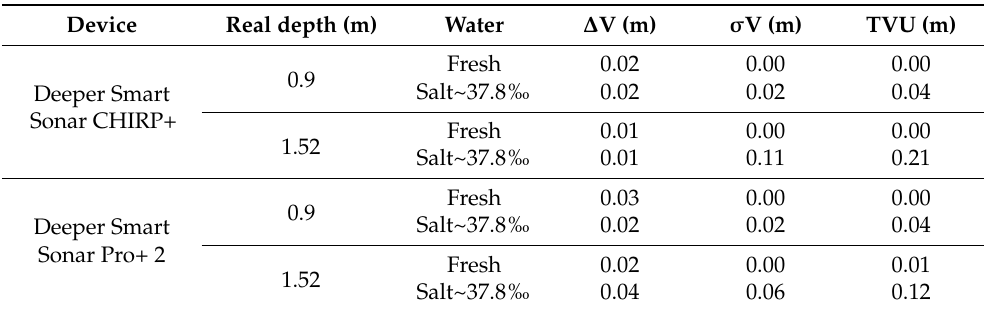
Table 13. Performance in depth measurement of Deeper Smart Sonar CHIRP+ and Deeper Smart Sonar Pro+ 2.